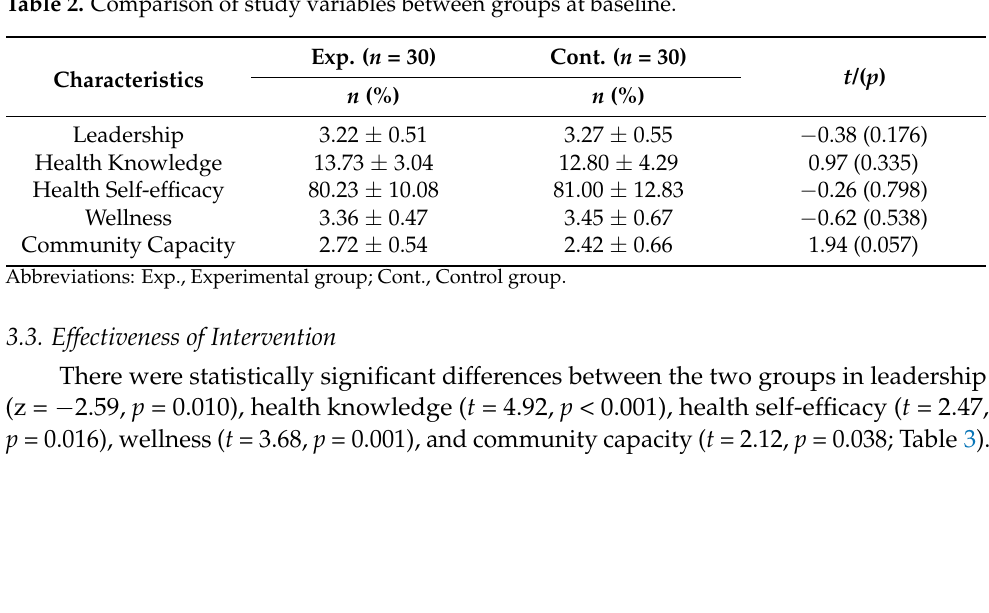
Table 2. Comparison of study variables between groups at